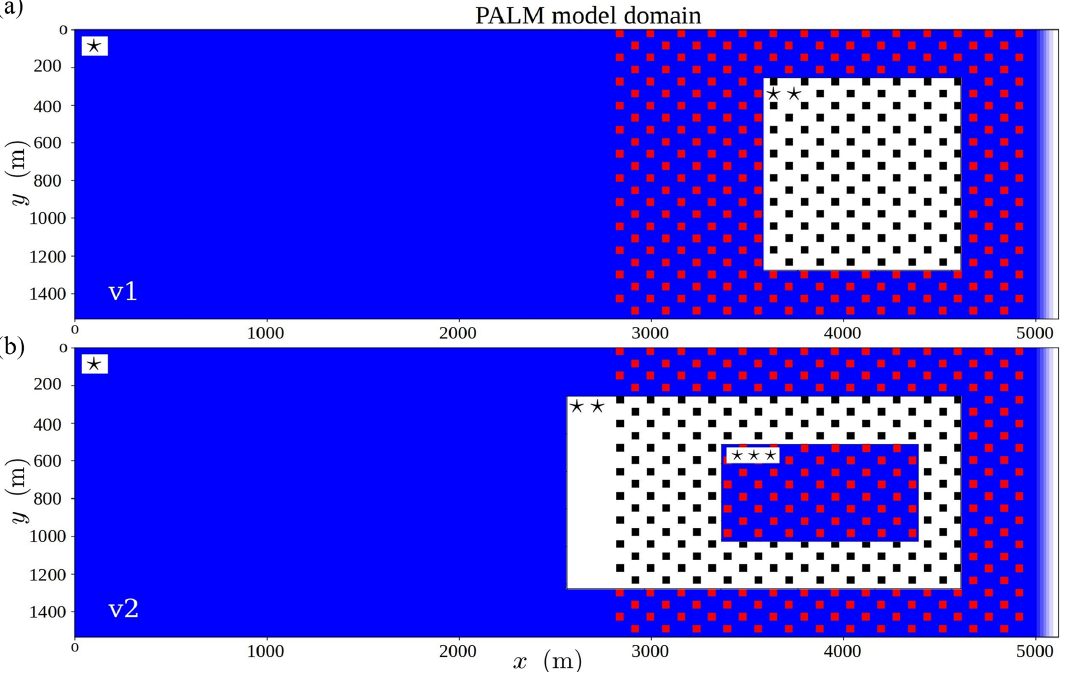
Figure 16. An overview of the cubical obstacle case layout. The obstacles are cubes with 40m sides. The figure displays two nested arrange- ments: version 1 (v1), featuring a root domain and a secondary nest domain, and version 2 (v2), which also includes a tertiary nest domain embedded within a larger secondary nest. The root and nested domains are indicated with ((cid:63)) , ((cid:63)(cid:63)) , and ((cid:63)(cid:63)(cid:63)) in the upper left-hand corner of each domain, respectively. The first child domain is displayed with a white background for better visualization.